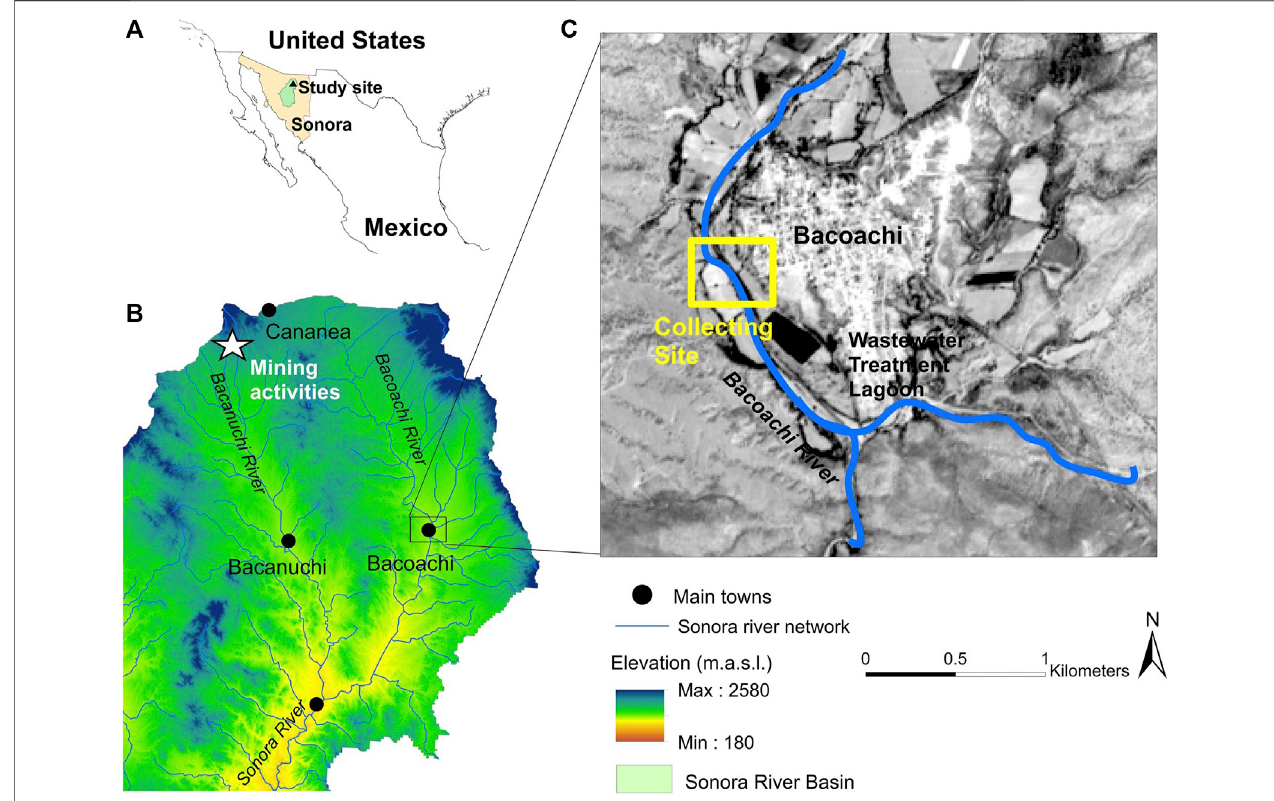
FIGURE 1 | (A) Map of the study site, (B) the location of the Cananea mining area (Bacanuchi river), and (C) Bacoachi site and town.